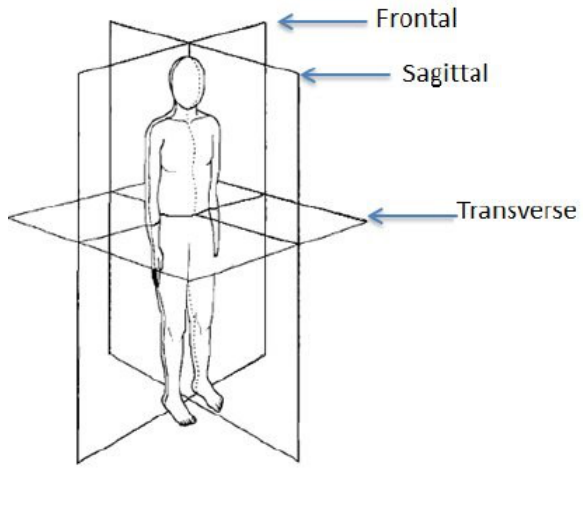
Figure 1. Cardinal planes of motion